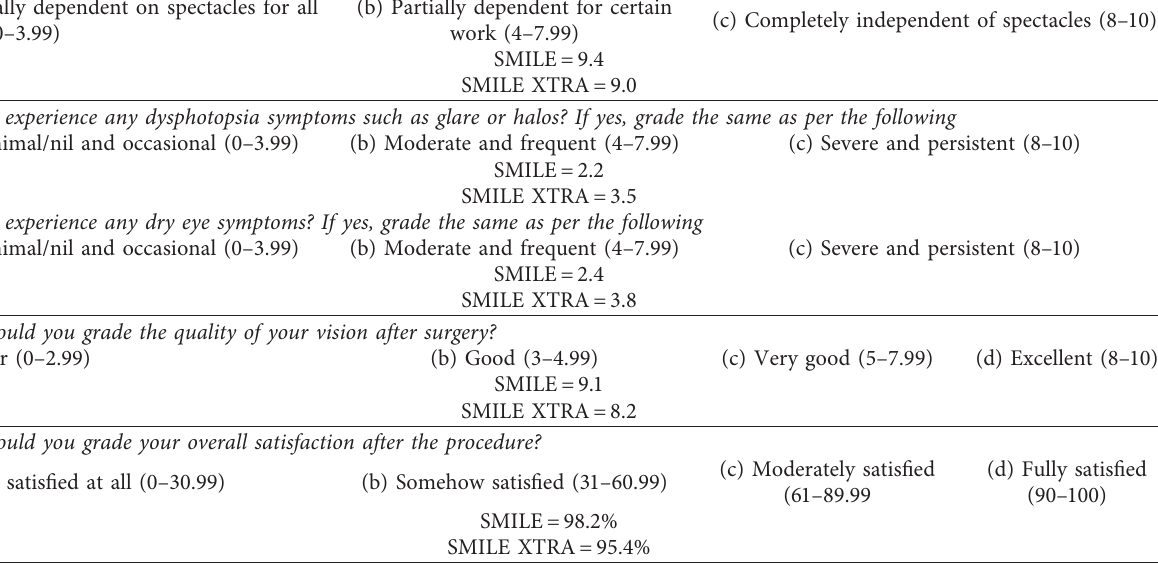
Table 5: Questionnaire and mean scores for evaluation of spectacle independence, patient satisfaction, and quality of vision. What is your level of spectacle independence after